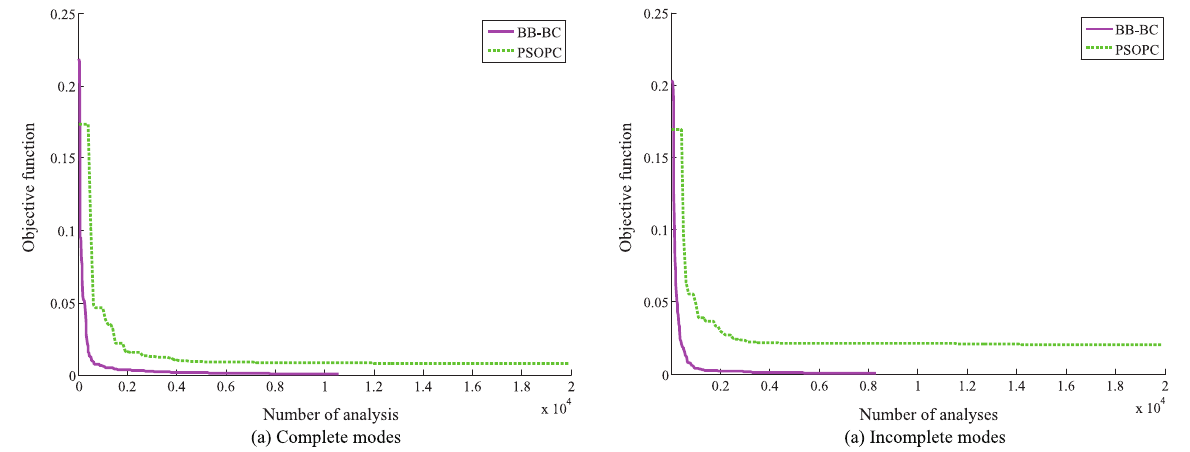
Fig. 17. The convergence history for the two-story two-bay frame structure in Scenario